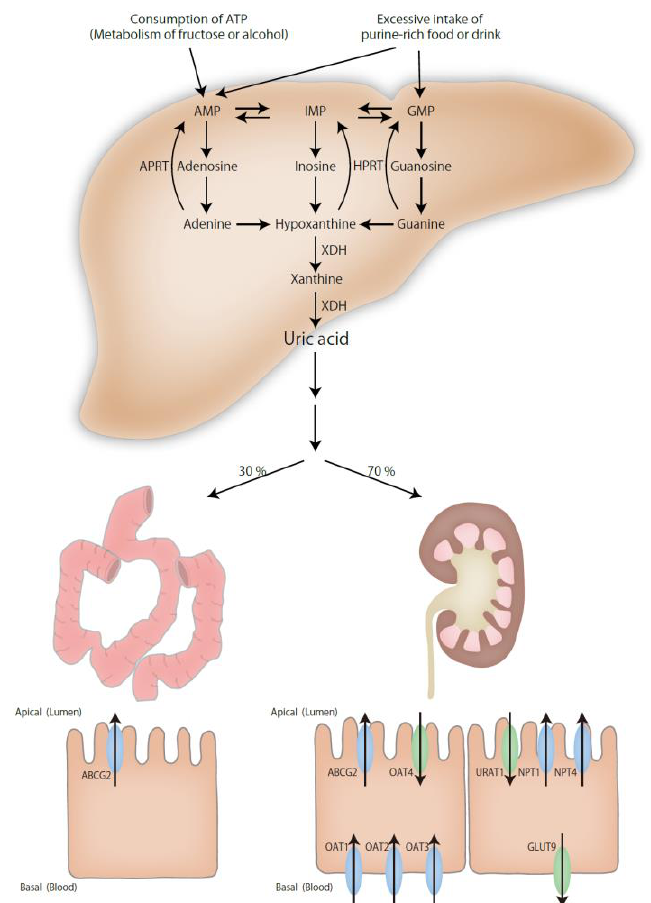
Figure 1. Mechanisms of hyperuricemia. Purine is metabolized to uric acid. Uric acid is excreted via the kidney and the intestinal tract. HPRT, hypoxanthine-guanine phosphoribosyl transferase; APRT, adenine phosphoribosyltransferase; XDH, xanthine dehydrogenase.